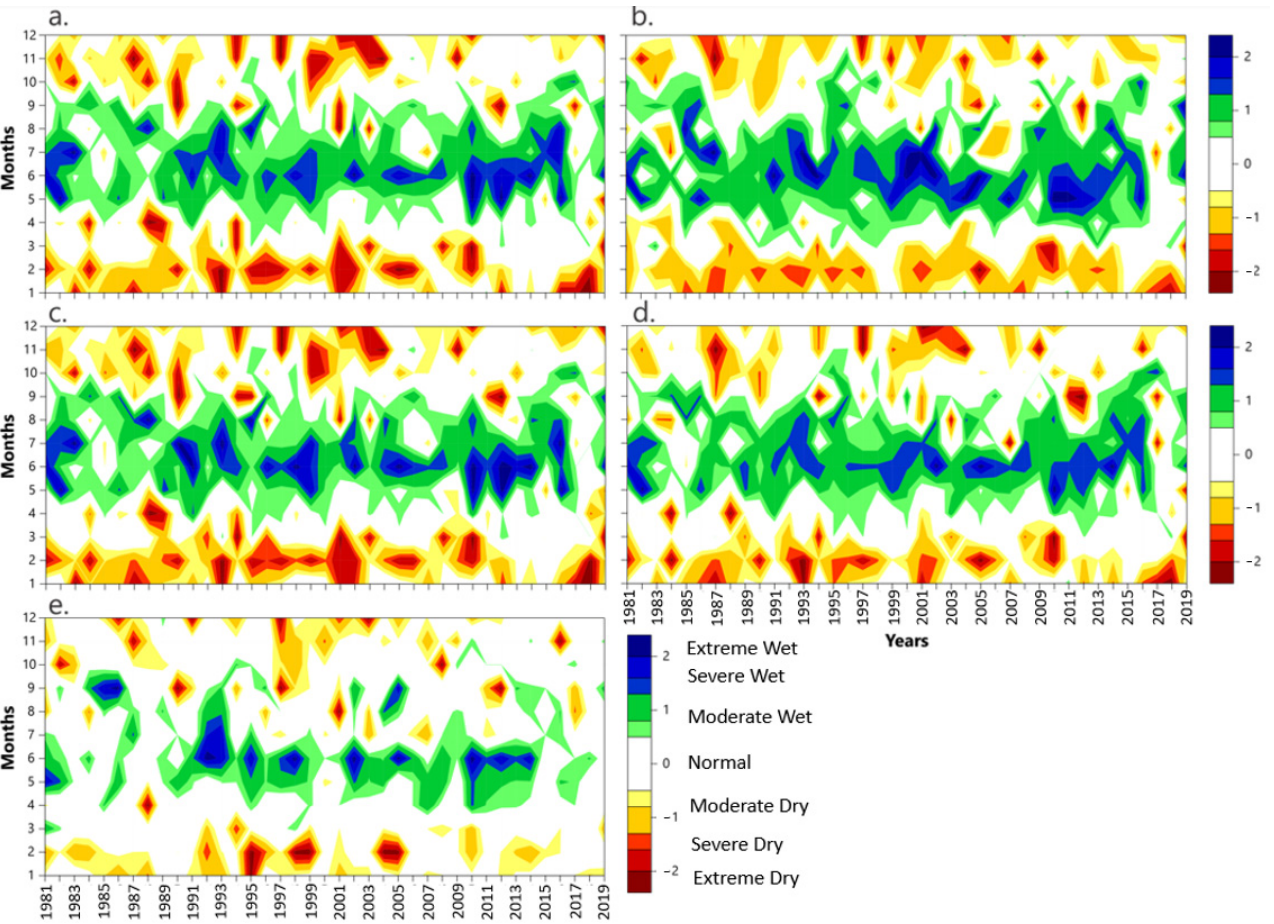
Figure 6. SPI derived from ERA5 data for the Mixed Ecoregion for Beechy ( a ), Coronach ( b ), Rock Point ( c ), Swift Current ( d ), and Taber ( e ) in the period 1981–2019.